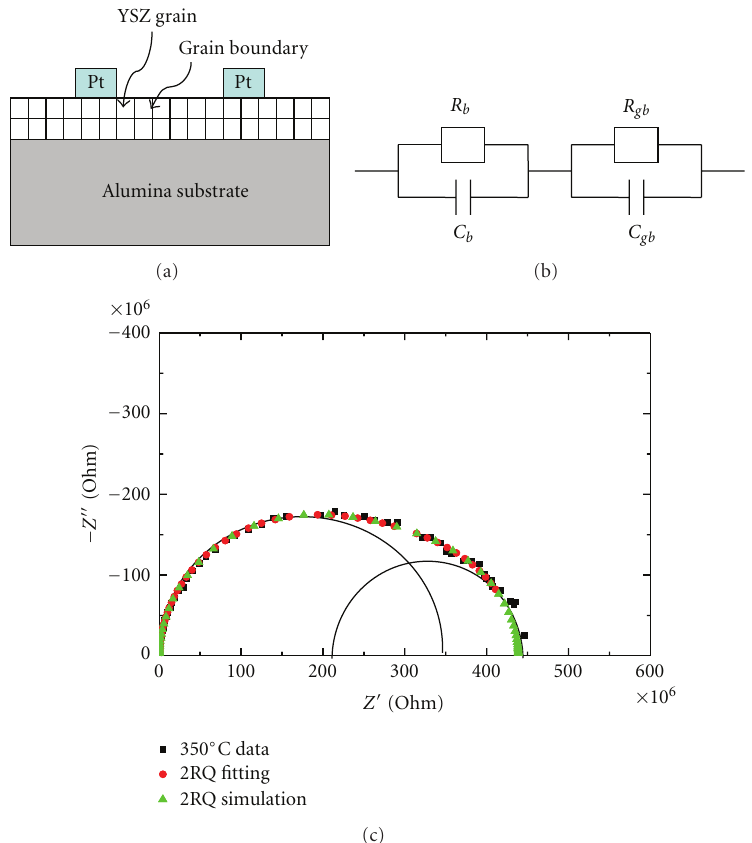
Figure 4: (a) Schematics of the specimen for conductivity measurement. (b) Equivalent circuit corresponding bulk and grain boundary conductions in polycrystalline ionic conductors. Q: constant phase element. (c) Typical Nyquist plot recorded at 350 ◦ C on 380nm thick YSZ thin film specimen after being oxidized at 800 ◦ C for